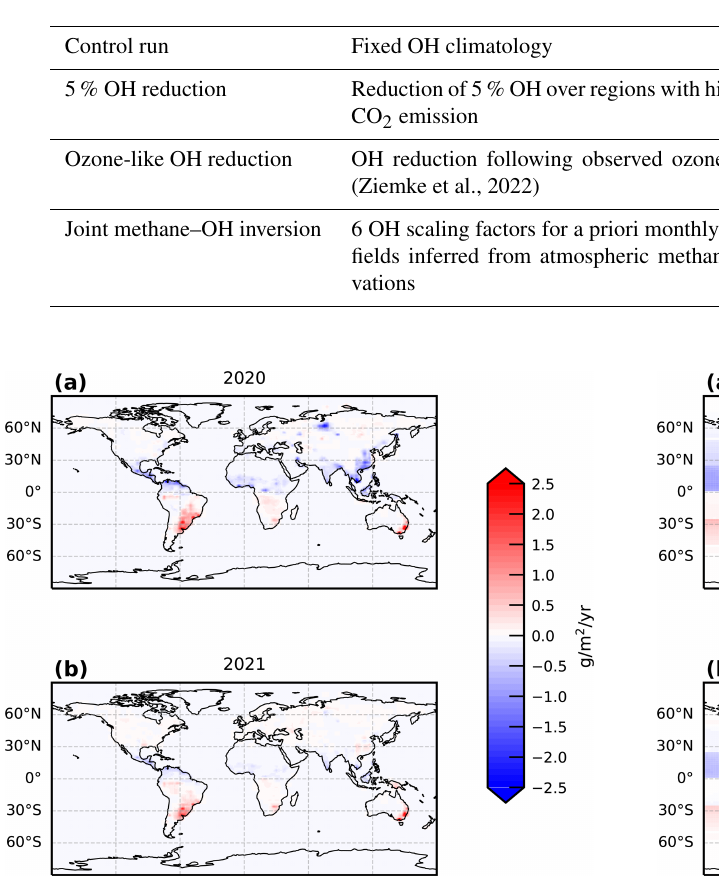
Figure 7. Annual mean difference of a posteriori methane loss due to OH oxidation (2020–2021) between the control inversion that uses OH climatology and the joint OH–flux inversion that estimates OH scaling